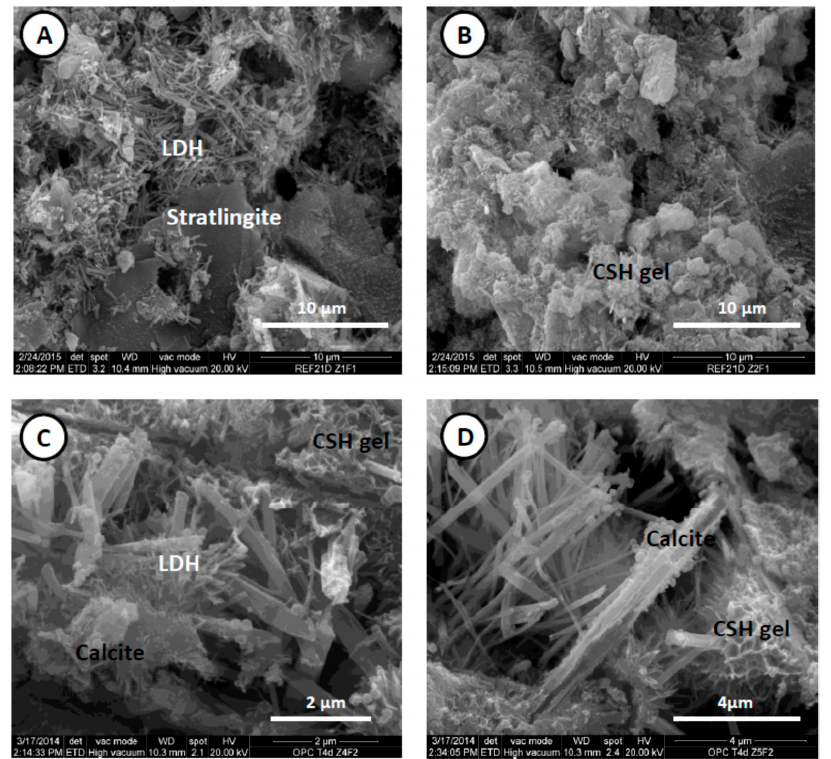
Figure 4. Morphological aspect of the CSH (Calcium silicate hydrate) gel, C4ASH12, and C2ASH8 phases at 600 °C/2 h ( A and B ). Morphological aspect of the CSH gel, C4AH13 and LDH (Layered double hydroxide) structures at 900 °C/2 h ( C and D ). ( A ) Layered double hydroxides with stratlingite; ( B ) Calcium silicate hydrate with spongy appearance; ( C ) Calcite crystal with typical morphology; ( D ) Calcite fibbers and layered double